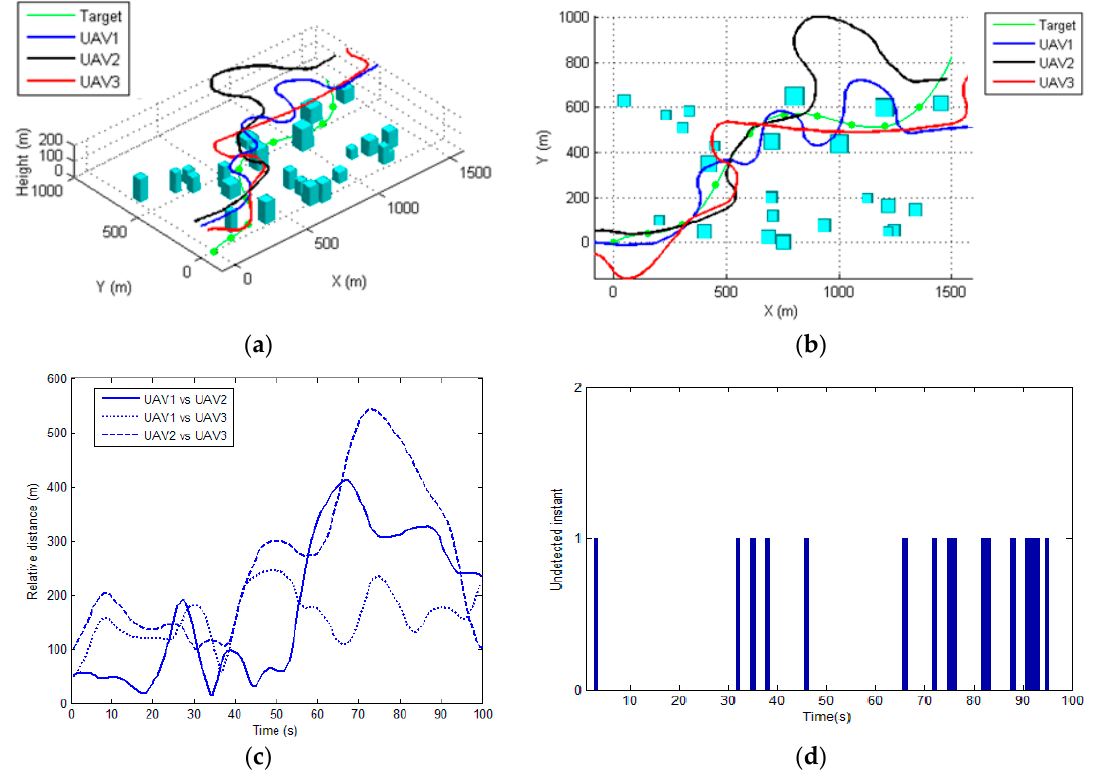
Figure 10. The results obtained by using LGVF based approach for scenario 1. ( a ) 3D view of the planned path for each UAV; ( b ) Top view of the resulting paths; ( c ) The relative distance between each UAV during tracking; ( d ) The undetected time-instant.